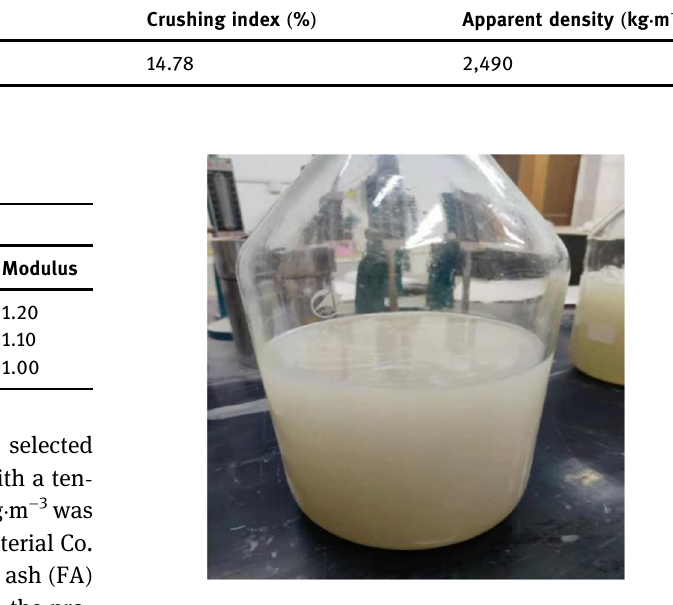
Figure 2: Alkali activator